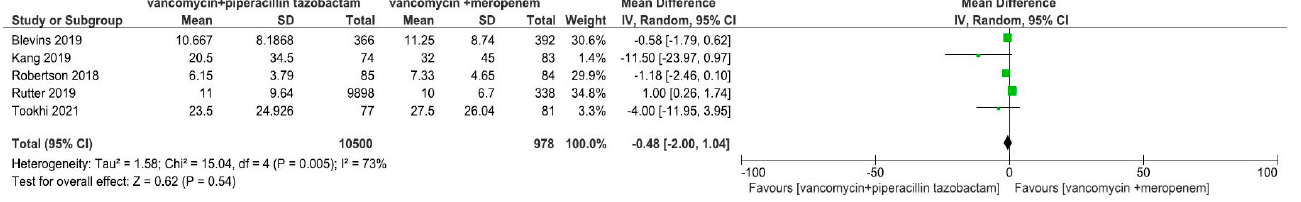
Figure 3. Length of stay (LOS) in hospital.